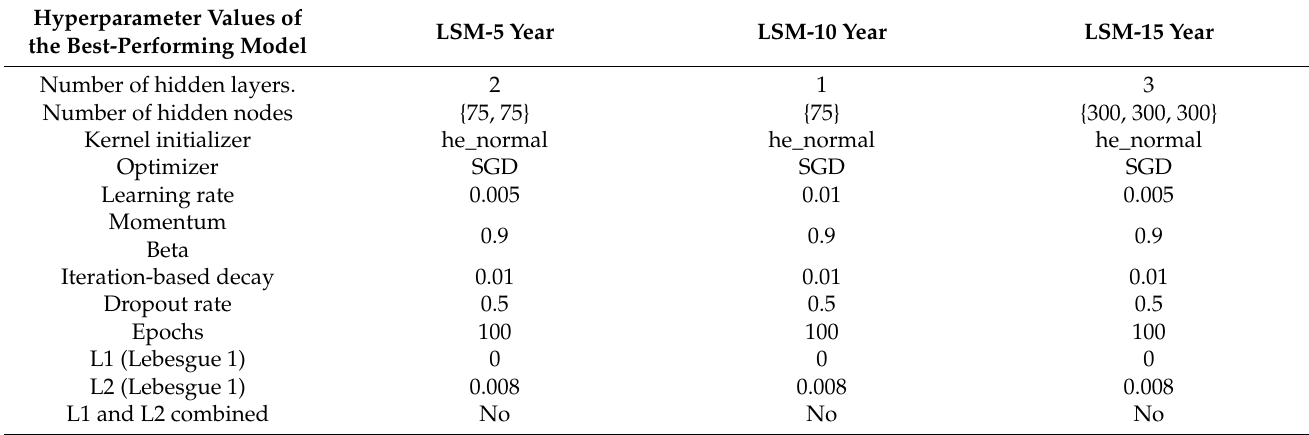
Table 4. The hyperparameter values of the best-performing DFNN models learned from 5-year, 10-year, and 15-year datasets, respectively (LSM: Lynn Sage Dataset for Metastasis).